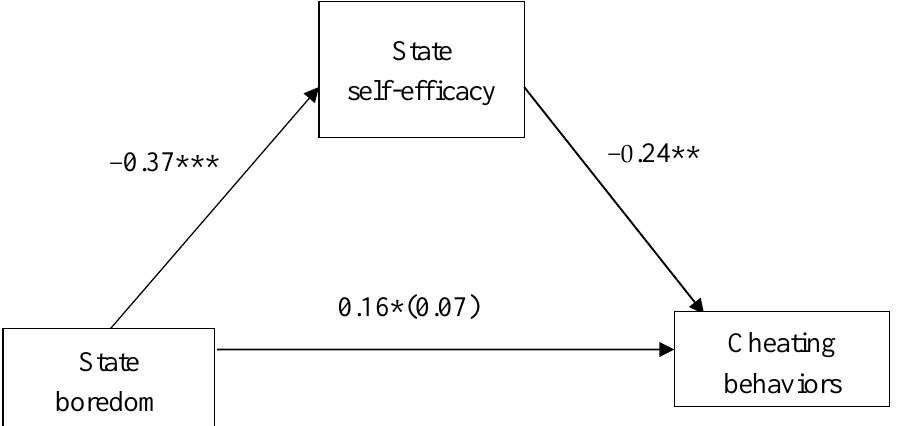
Figure 1. Regression coefficients for the correlation between state boredom and cheating behaviors mediated by state self-efficacy. * p < 0.05, ** p < 0.01, *** p < 0.001